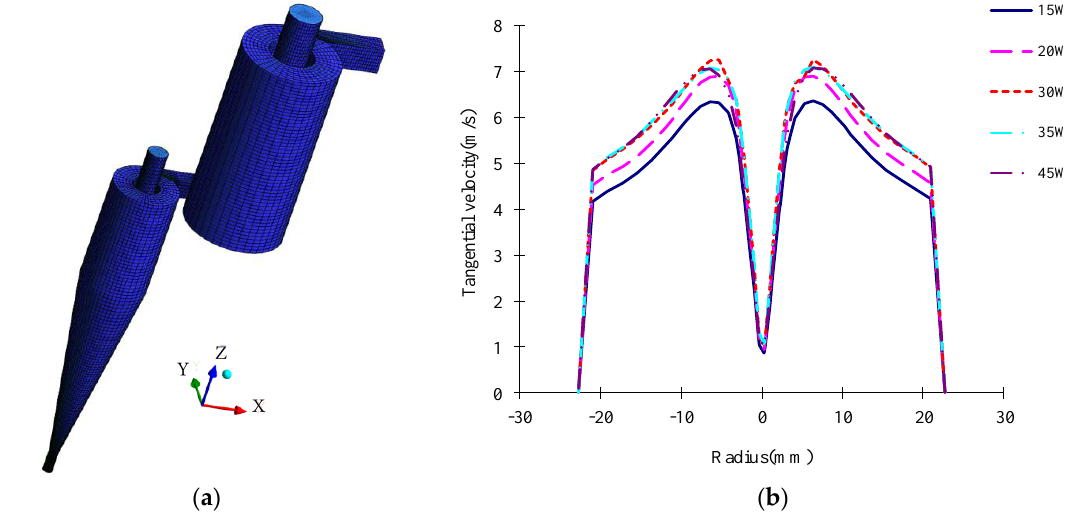
Figure 2. The mesh of TS hydrocyclone: ( a ) mesh; ( b ) mesh independence detection.